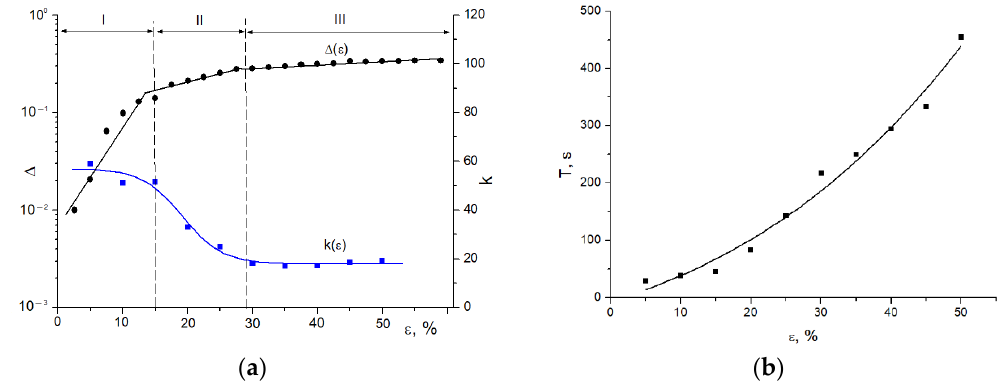
Figure 8. Dependences of total strain ε during tensile of polycrystalline Ni in the load–unload mode: ( a ) damage parameter in ln Δ ( ε ) coordinates and concentration k-criterion of damage for PLC bands in direct coordinates; ( b ) time period of PLC bands.